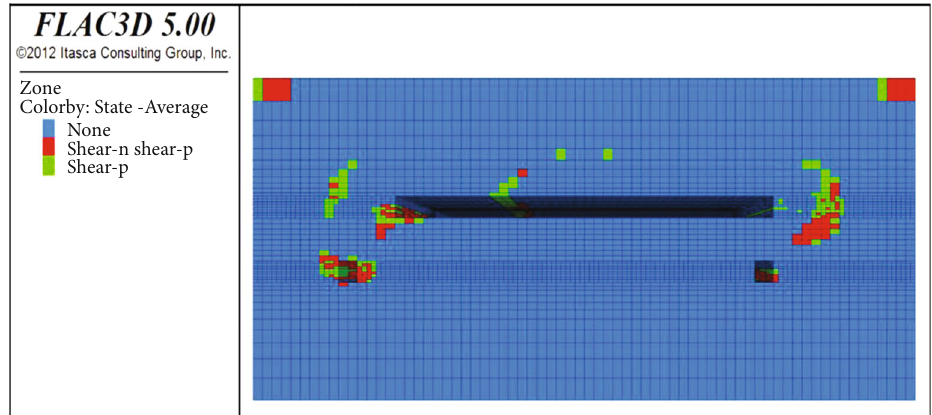
Figure 14: Distribution of elastic-plastic zone in surrounding rock of mining